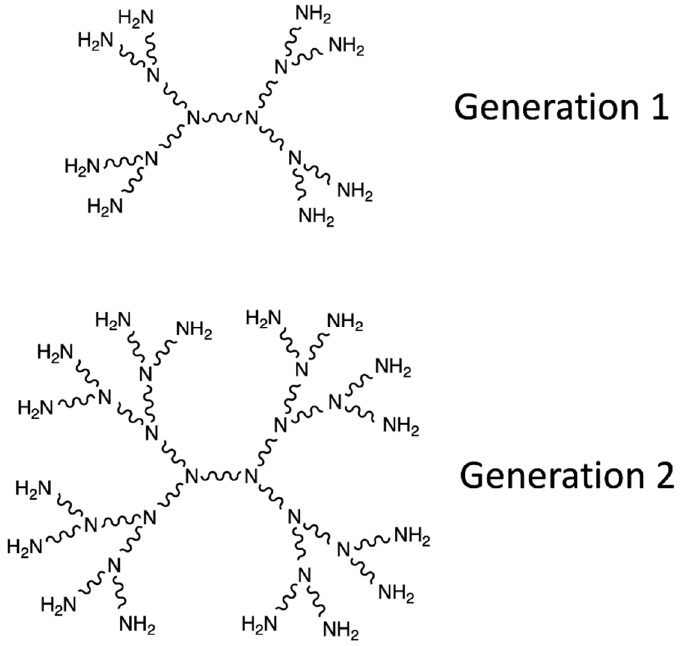
Figure 9. Tetrafunctional synthesis of polyamidoamine (PAMAM). Comprehensive Michael ad- dition of amine groups with methyl acrylate, followed by amidation of the ester resulting from ethylenediamine. Adapted and modified from [143], Drug Discovery Today, 2001.